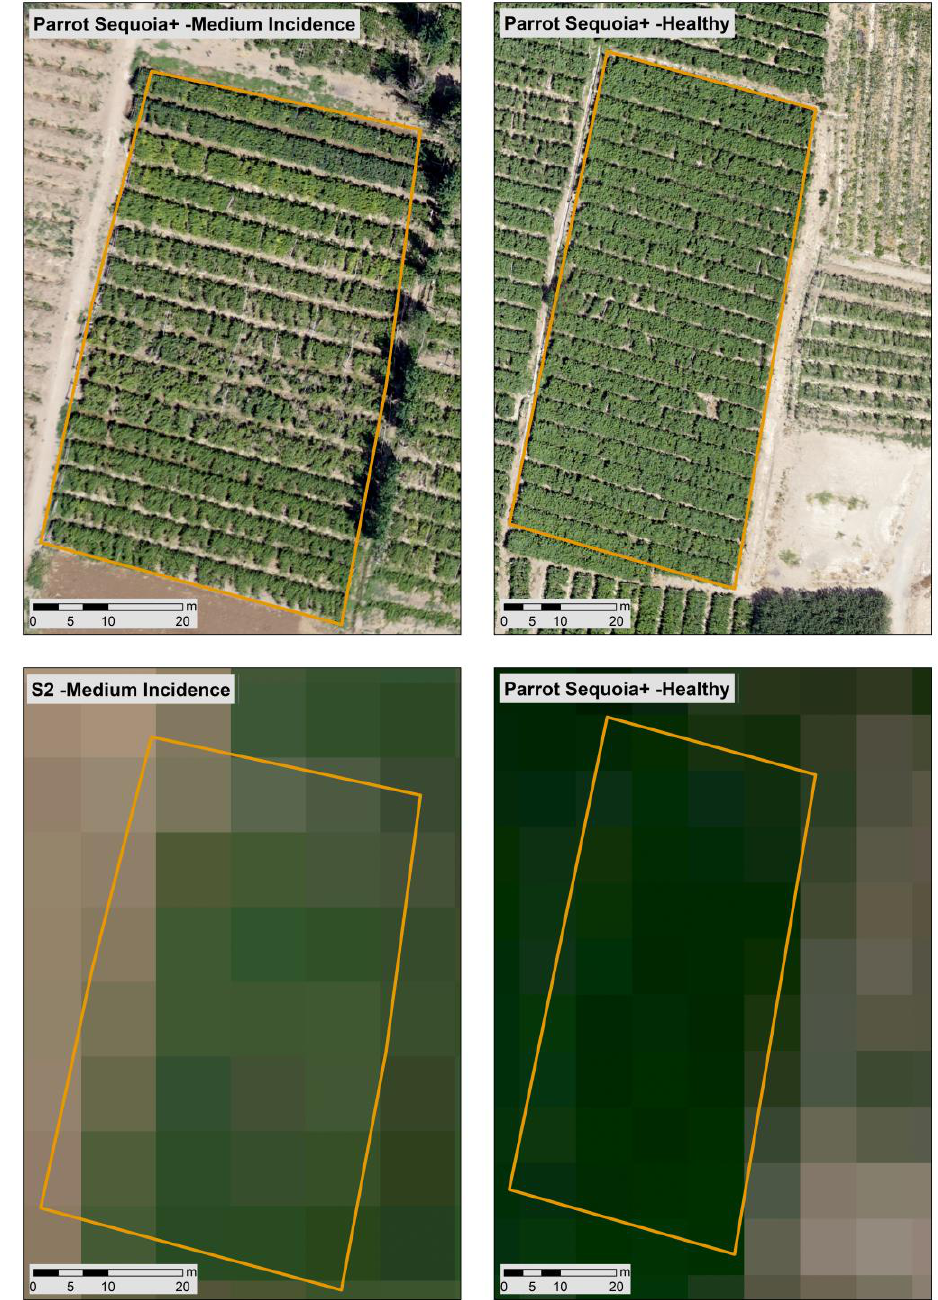
Figure 5. Example of vineyards with different pests and diseases incidences viewed by a high-resolution RGB camera and Sentinel-2. ( Left ) panels show medium incidence, and ( right ) panels show a healthy vineyard.